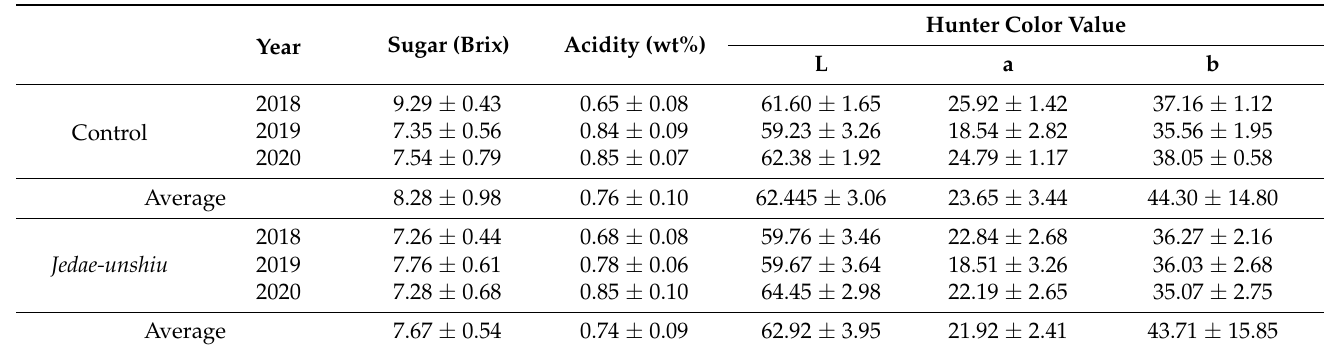
Table 2. Comparative analysis of sugar, acidity, and hunter color value between control and Jedae- unshiu fruits.